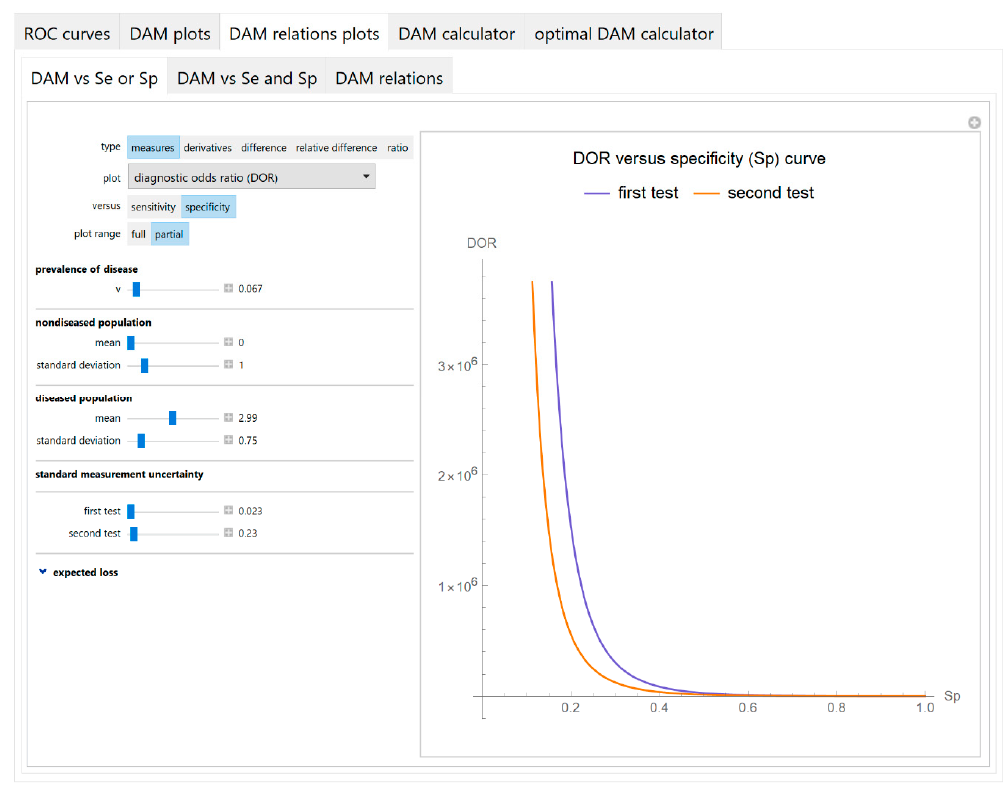
Figure 7. DAM relations plots module, DAM against sensitivity or specificity submodule screenshot. Diagnostic odds ratio ( DOR ) of two screening or diagnostic tests measuring the same measurand with different uncertainties, against specificity ( Sp ) curve plot, with the settings shown at the left.